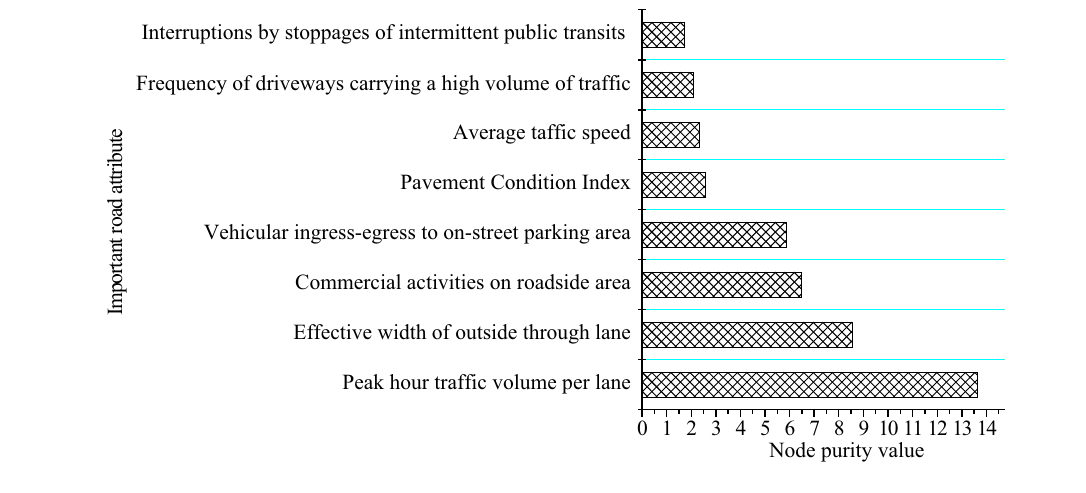
Fig. 3 Node purity values of important road attributes